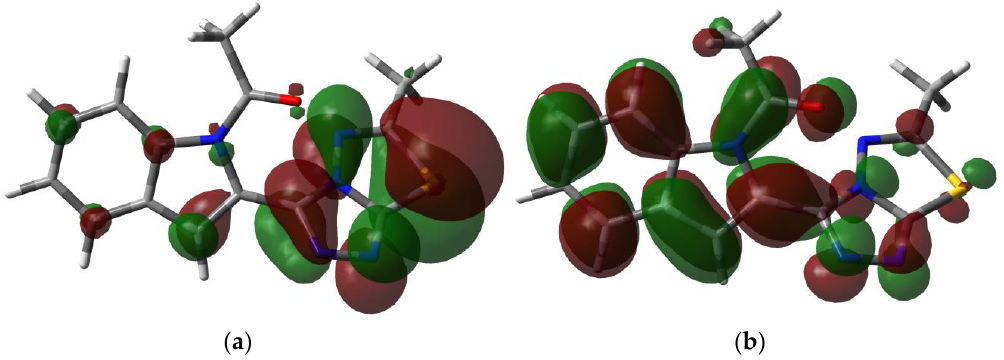
Figure 11. HOMO ( a ) and LUMO ( b ) orbital density of the studied compound.